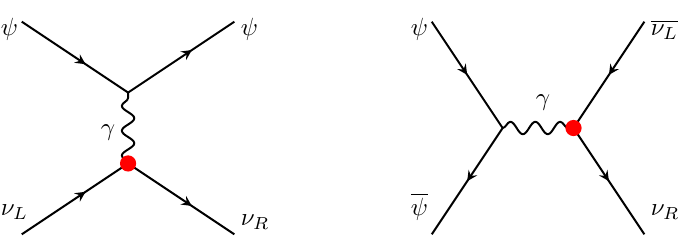
Figure 1 . The t - and s -channel scattering processes for ν R production in the early universe. The red blobs denote neutrino magnetic moments and ψ denotes a generic charged